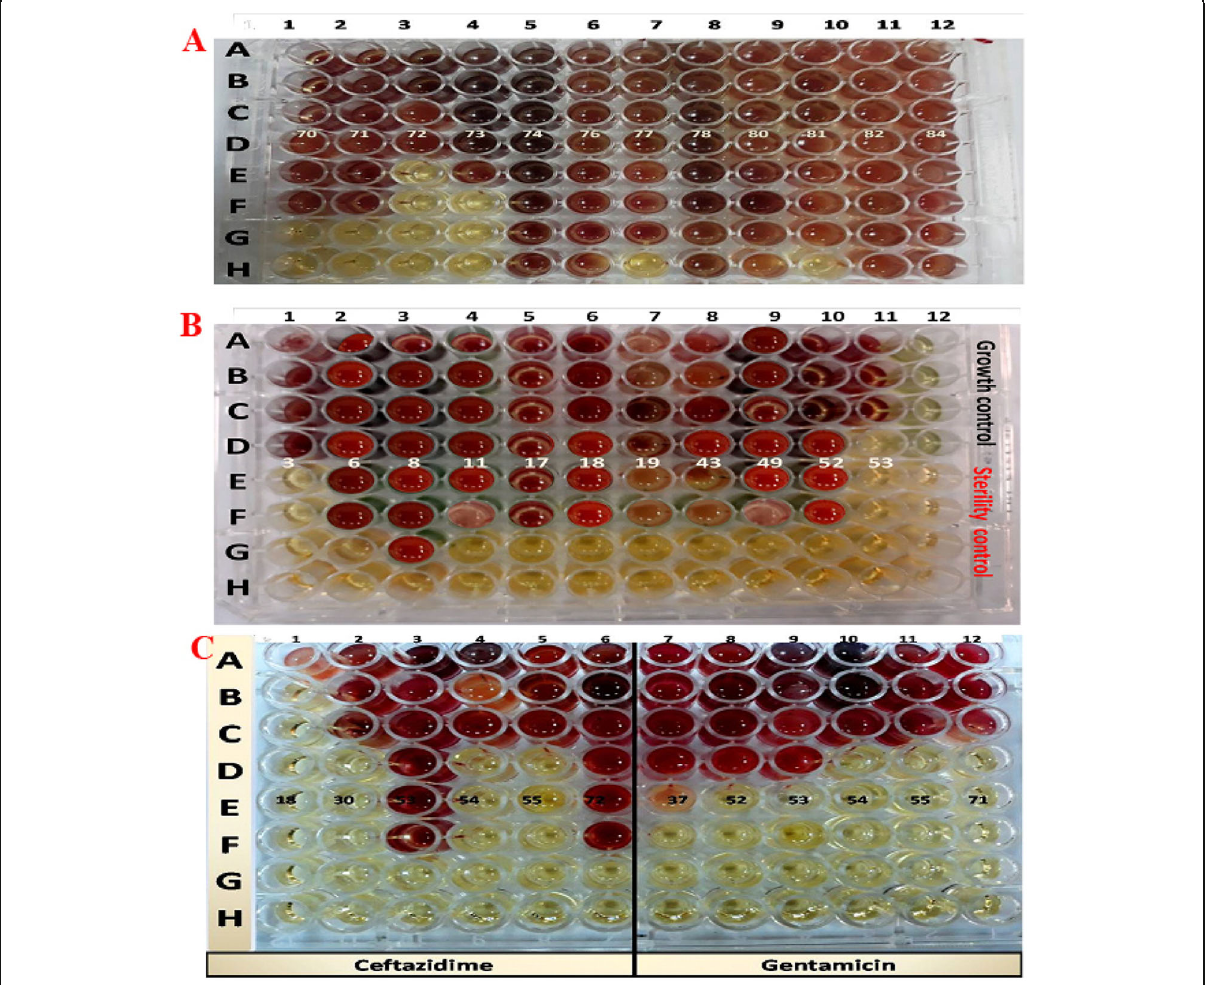
Fig. 2 A schematic representation of the 96-well of broth microdilution model using TTC showed resistance pattern of P. aeruginosa isolates to ( a) imipenem antibiotic. b meropenem. c ceftazidime and